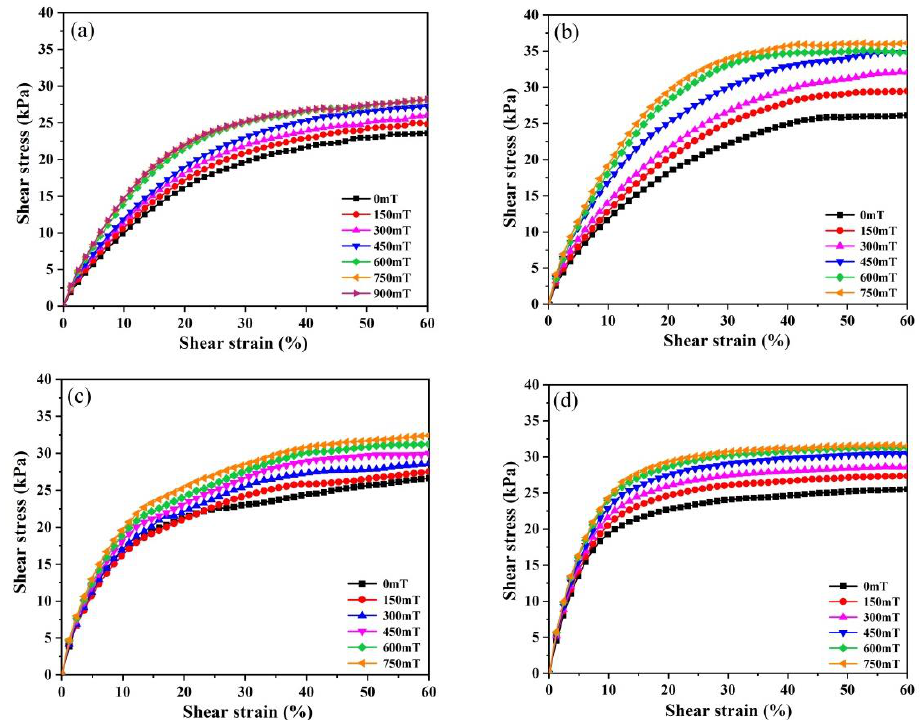
Figure 5. Steady-state stress–strain curves of the MREs under various magnetic fields: ( a ) MRE-0; ( b ) MRE-1; ( c ) MRE-3; and ( d ) MRE-5.